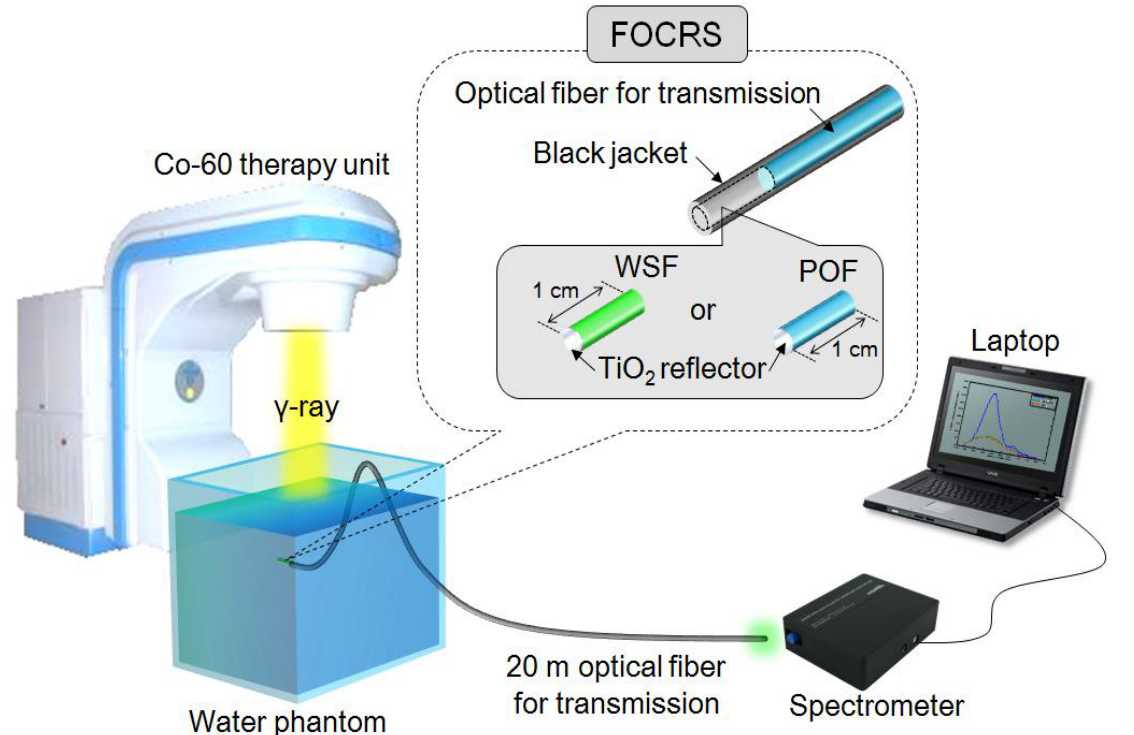
Figure 3. Structure of fiber-optic Cerenkov radiation sensors and experimental